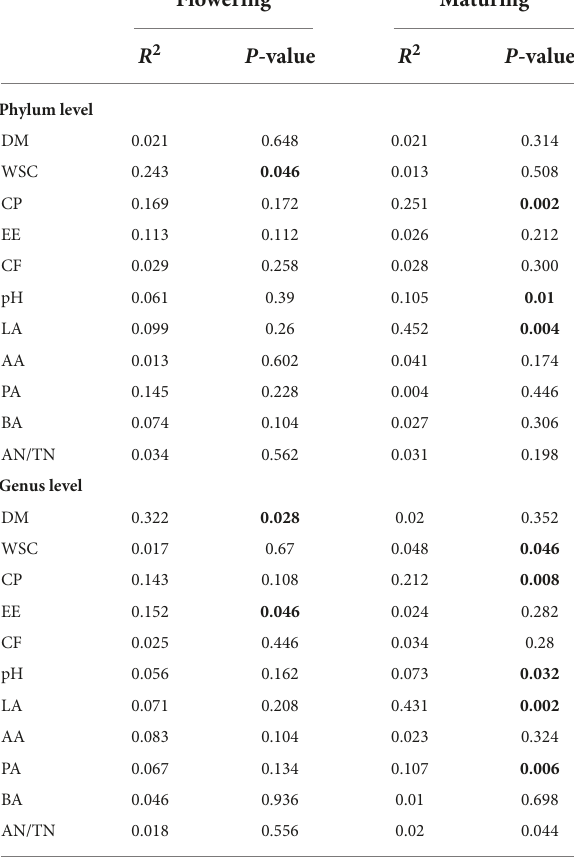
TABLE 5 The Mantel test (permutations = 999) among chemical composition, fermentation products, and bacterial microbial communities at phylum and genus level at flowering and maturing stage.